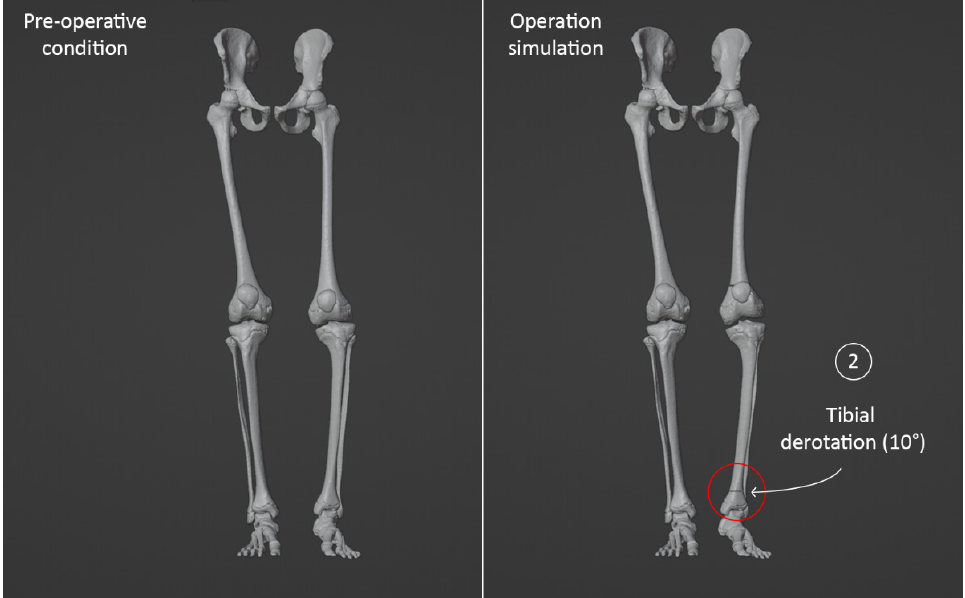
Figure 12. Comparison between the baseline appearance of the 3D model and the same model after both femoral and tibial osteotomies, showing that the patella and foot are pointing forward.